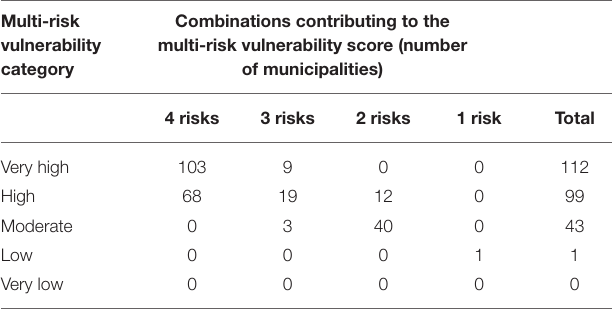
Multi-risk vulnerability category of